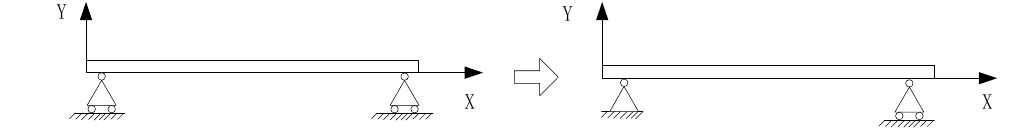
Figure 2. Model switch of simply supported beam model.